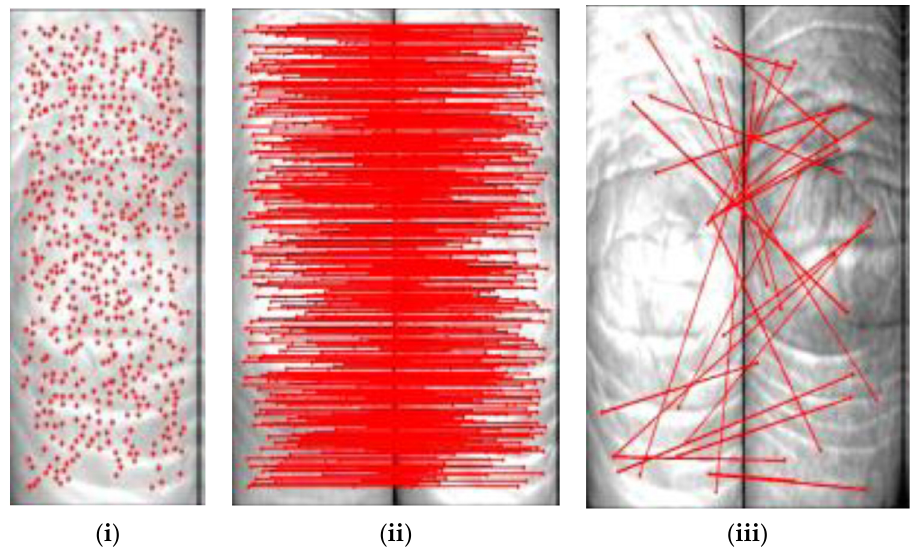
Figure 6. ( i ) SIFT points ( ii ) Matched points ( iii ) Non-matched points.